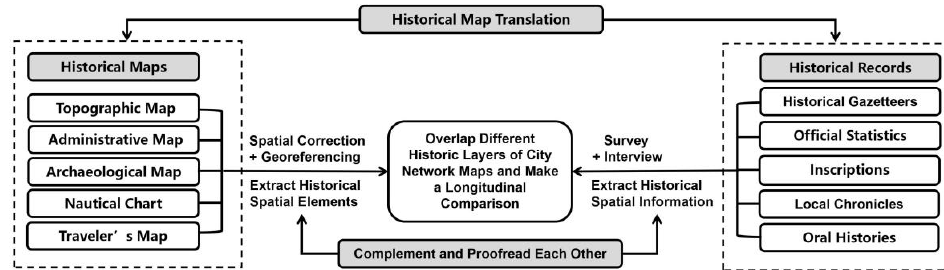
Figure 3. Historical map translation method based on multiple sources. Source: the authors.